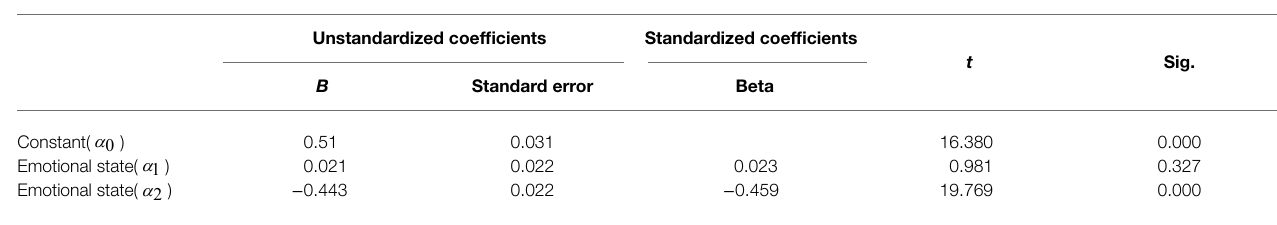
TABLE 12 | Coefficients between identification accuracy and emotional valence.